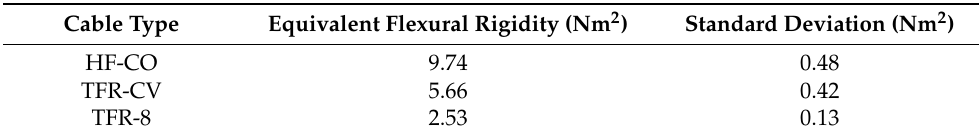
Table 5. Equivalent flexural rigidity for various types of electric power